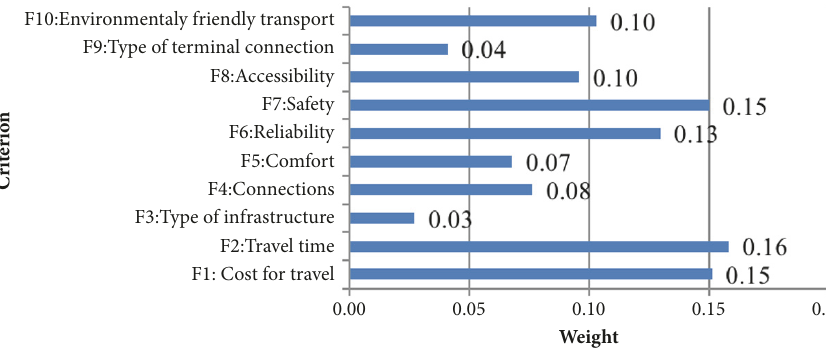
Figure 8: Weights of